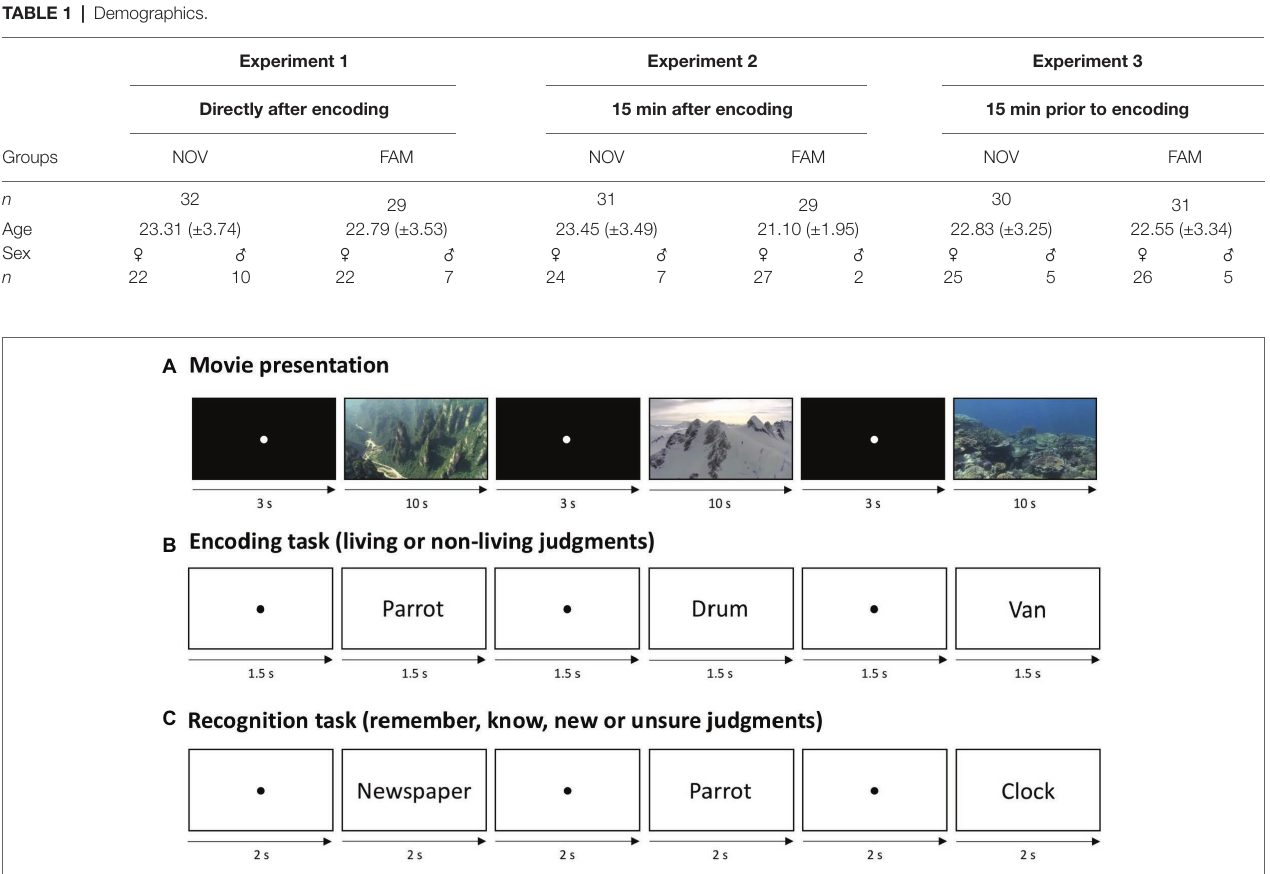
FIGURE 1 | Experimental design. (A) In all three experiments, subjects watched either novel (NOV group) or five repeating (FAM group) movie clips for 13 min. The movies were presented directly after (experiment 1), 15 min after (experiment 2) or 15 min prior to (experiment 3) encoding. (B) During encoding, participants classified nouns into “living” vs. “non-living” by button presses. (C) On the second day, all 100 words from the encoding phase were presented intermixed with 100 new words, and participants classified them into “remember”, “know”, “new,” or “unsure.”